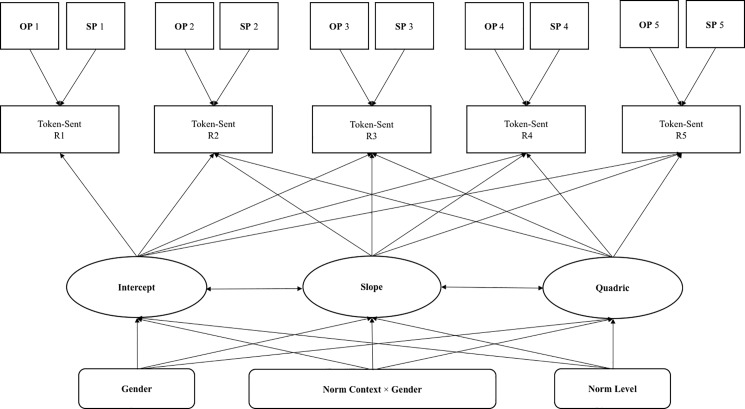
Hypothetical quadratic latent growth-curve model with covariates.